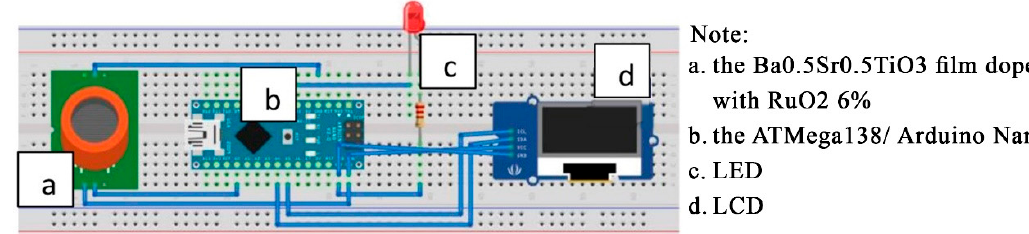
Figure 7. Sketch of the prototype’s electronic circuitry.